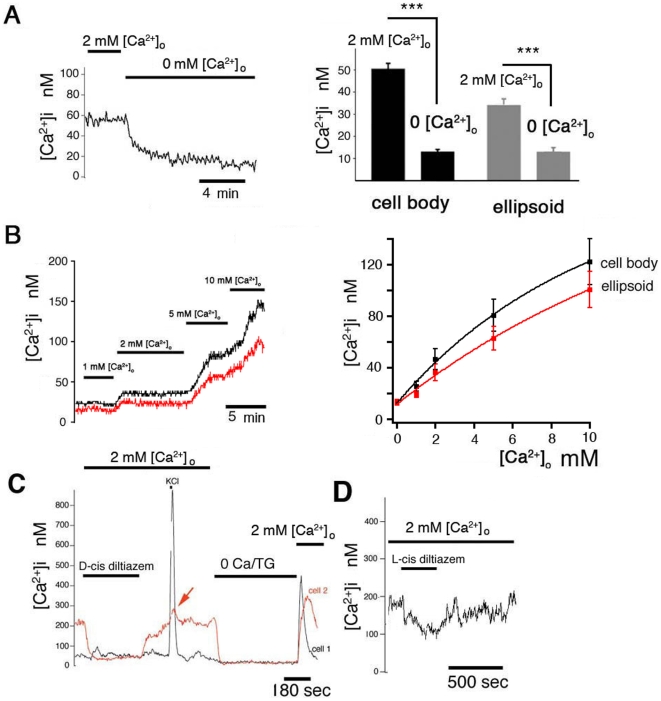
Ca2+ influx in the light adapted cone inner segment.(A) Removal of extracellular Ca2+ causes a sustained decrease in [Ca2+]i in the cone perikaryon and ellipsoid. (B) Left panel: Cytosolic [Ca2+] in the cell body (black trace) and the ellipsoid (red trace) is a quasi-linear function of the driving force for Ca2+ entry. Ca2+ concentration in extracellular saline was modulated between 0 and 10 mM. Right panel: Cumulative data combining [Ca2+]i responses to changes in [Ca2+]o. Data was fit with an exponential function. (C) Simultaneous recording from the two members of a double cone exposed to 200 µM D-cis diltiazem and 20 mM KCl. Cone 1 (principal member; black trace) was unaffected by diltiazem and responded strongly to depolarization. Following depletion of Ca2+ stores in 0 Ca2+/TG, the cell exhibited a fast monophasic increase in [Ca2+]i. Cone 2 (accessory member; red trace) had a high initial baseline [Ca2+]i which was lowered by diltiazem to ∼50 nM. Its response to depolarization was minimal (arrow). Depletion of internal stores triggered a monophasic overshoot in [Ca2+]i in both cells. (D) L-cis diltiazem (10 µM) elicited a sustained decrease in [Ca2+]i.